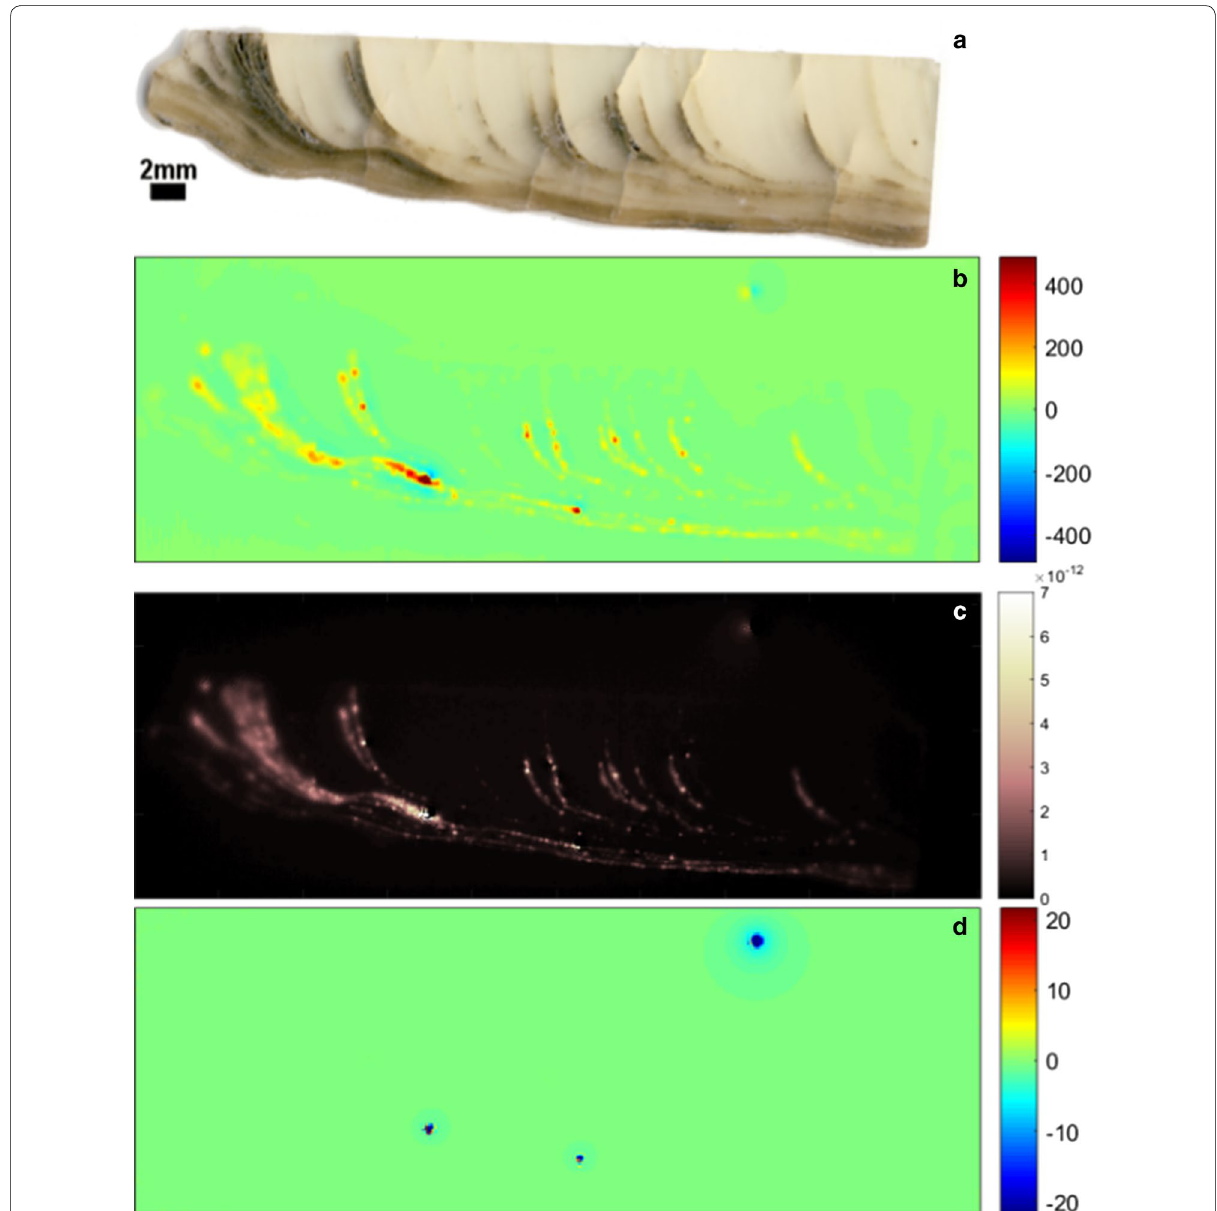
Fig. 10 Inversion results for the SVC982 speleothem: a an image of the SVC982 speleothem, b the SIRM B z field map (the positive direction is out of page) obtained by scanning SQUID in nT with the color range scaled to show all the flood layers (the maximum intensity is 3256.4 nT), c the SIRM magnetic moments found using the TNT-NN unidirectional inversion (dipoles out of page) in Am 2 with 100 µ m dipole spacing, and d the solution residuals in nT. The high-magnitude residuals located in the upper right of ( d ) are attributable to contamination present during scanning SQUID data acquisition. The field of view for the bottom three images is 50.1 mm × 18.1